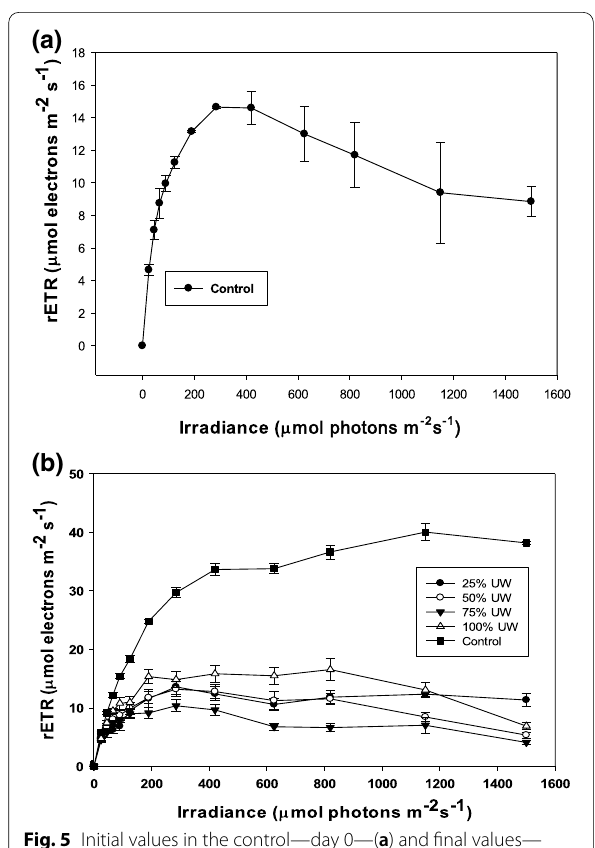
Fig. 5 Initial values in the control—day 0—( a ) and final values— day 14—in the control and UW treatments ( b ) of the electron transport rate (rETR) as a function of irradiance. Data are expressed as mean standard deviation (n ± =